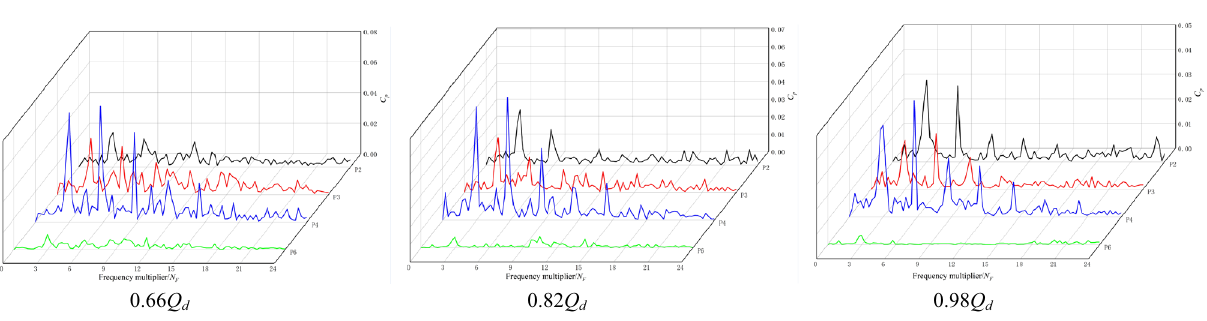
Figure 11. Time-domain diagram of pressure fluctuation under RPC.